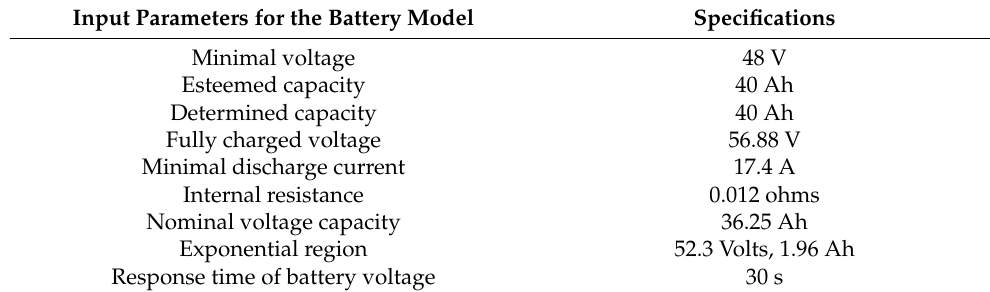
Table 3. Specifications of Li-ion